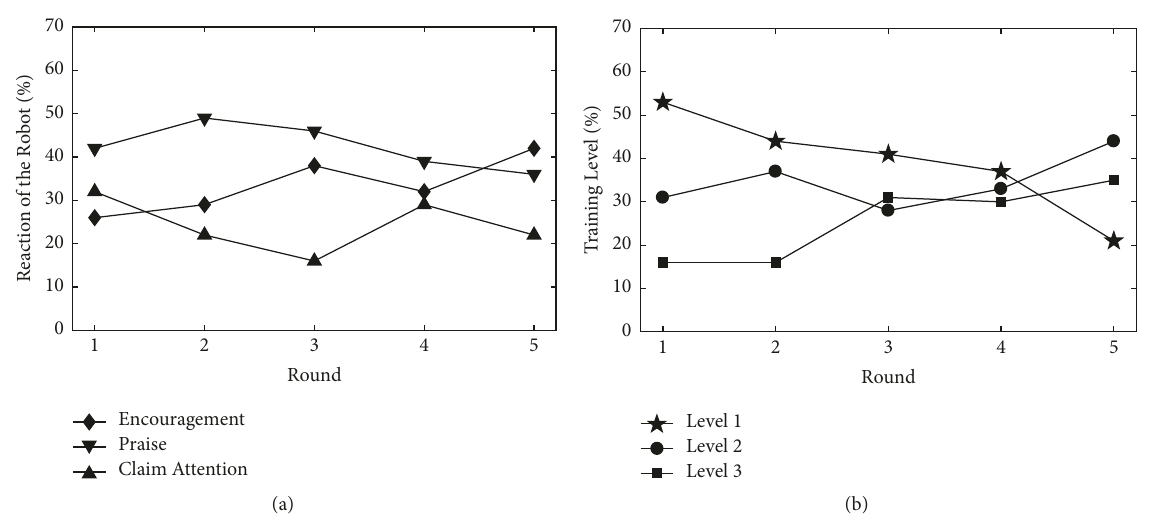
Figure 13: The distribution rate of training levels and the robot’s feedback for the child B in the